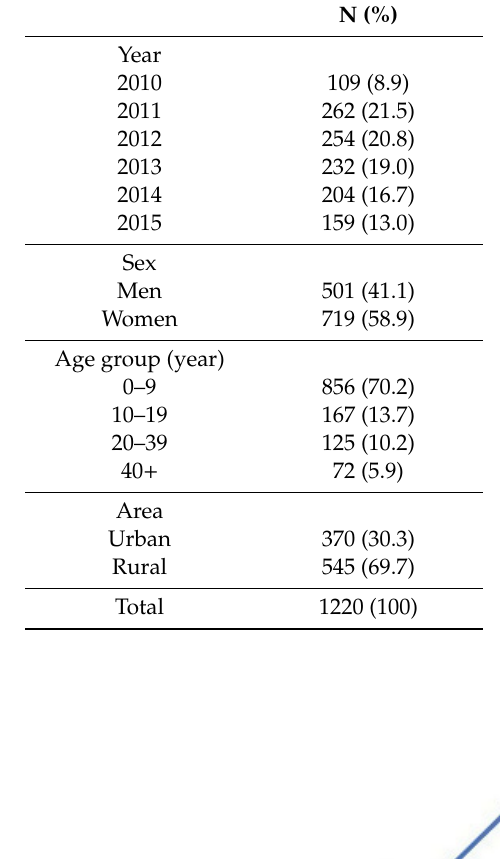
Table 1. Characteristics of congenital heart disease patients in the study, 2010–2015.